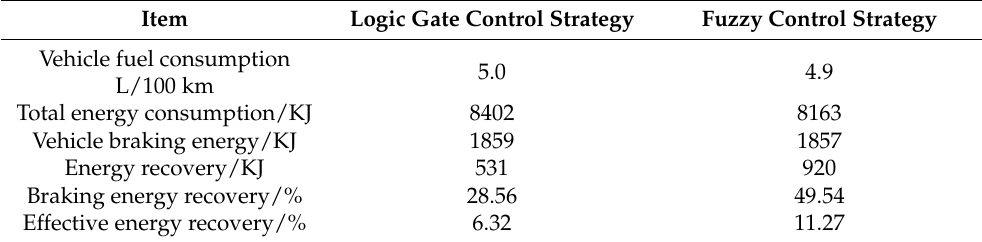
Table 8. Comparison of vehicle energy